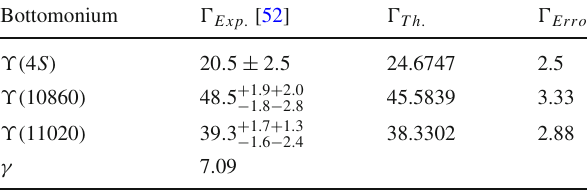
Table 17 The calibration of the parameter γ in the 3 P 0 model. (cid:16) Exp . and (cid:16) Th . denote the experimental and theoretical widths, respectively. (cid:16) Error represents fitting error. For b 100 χ 2 / n = 1 . 2229 where n = 3. All width results are in units of MeV Bottomonium (cid:16) Exp . [52] (cid:16) Th . V M e 16 79 .